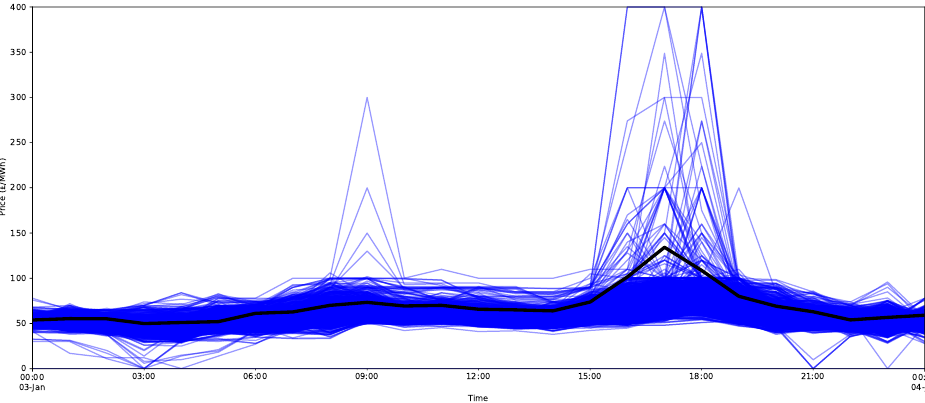
Figure 26. All 2000 bootstrap ensembles (blue) for the X-model method for 3 January 2019. The true price is in